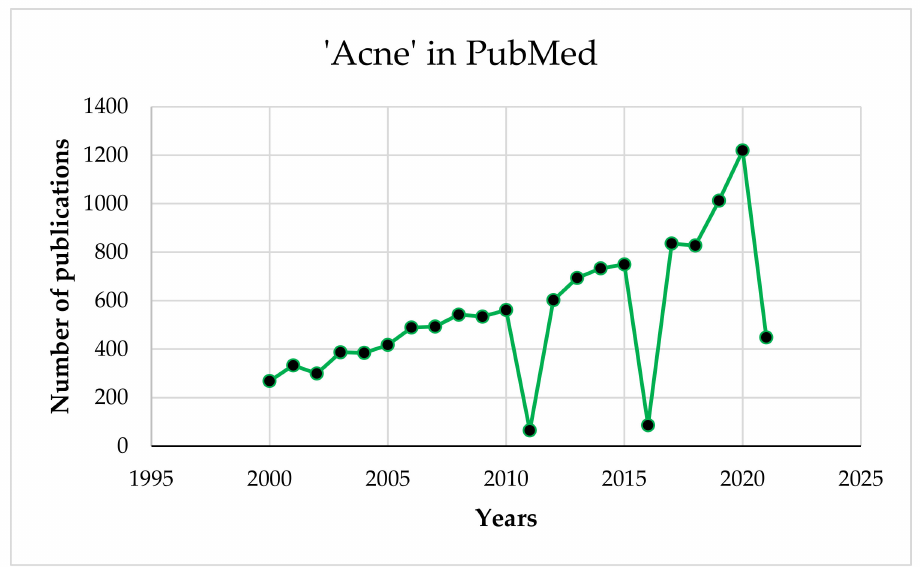
Figure 1. PubMed search results for ‘acne’ from 2000 to